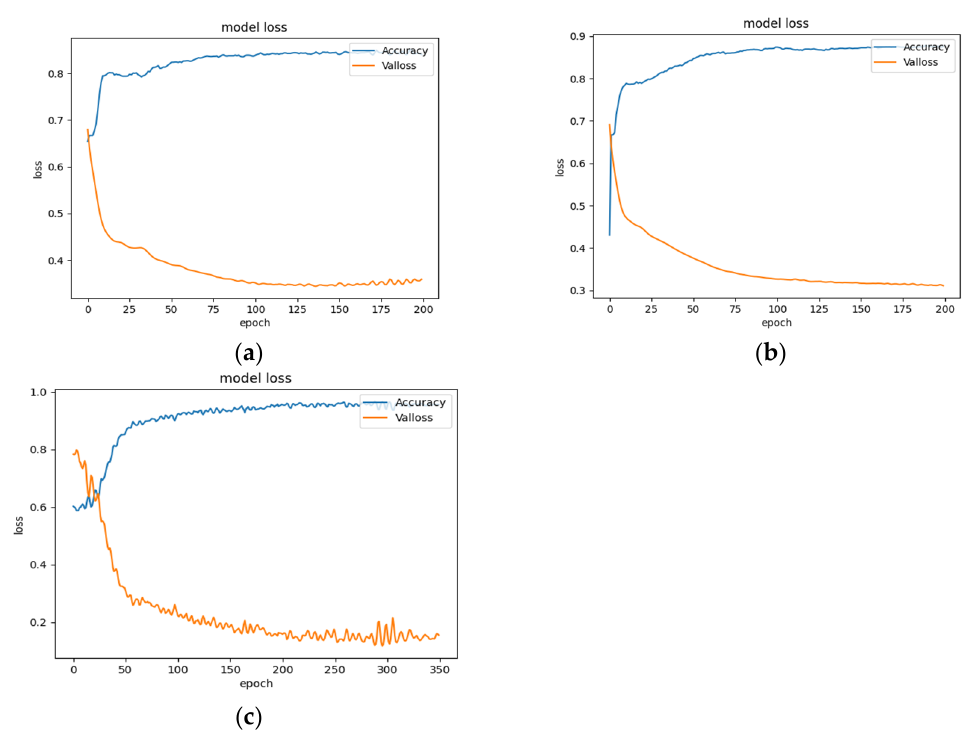
Figure 9. Curves of loss value and accuracy during training. ( a ) CVD. ( b ) CVT. ( c ) CVP.